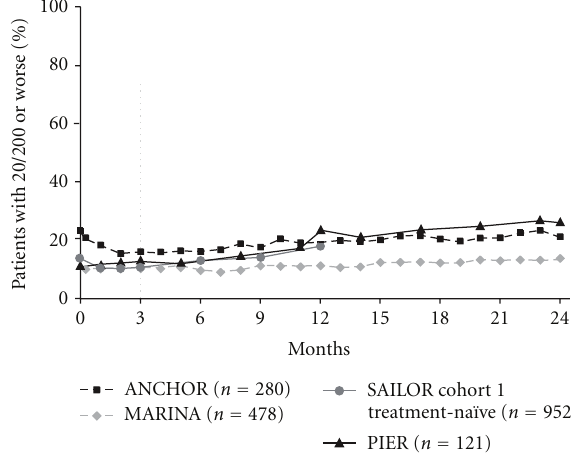
Figure 6: Percentage of patients with 20/200 or worse vision over time among pooled ranibizumab-treated patients by clinical trial. Dosing: ANCHOR and MARINA, monthly; PIER, months 0, 1, 2, 5, 8, 11, 14, 17, 20, and 23; SAILOR, months 0, 1, and 2, then as needed. Vertical line indicates switch from monthly to quarterly and as-needed dosing in PIER and SAILOR, respectively. ANCHOR: n = 279 at month 0; SAILOR cohort 1 treatment-na¨ıve: n = 946 at month